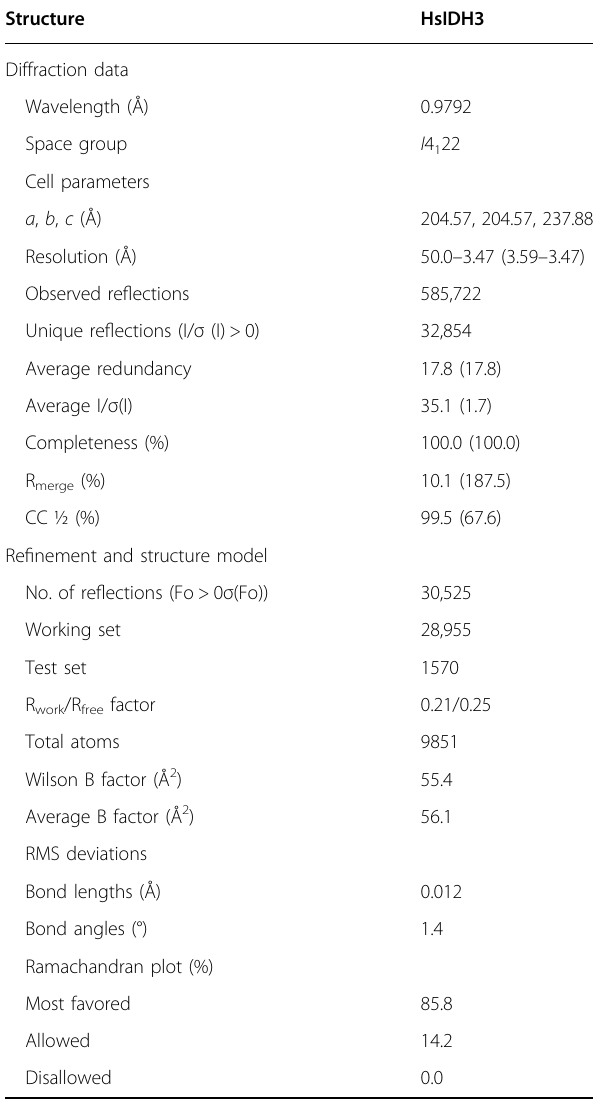
Table 1 Statistics of X-ray diffraction data and structure re fi